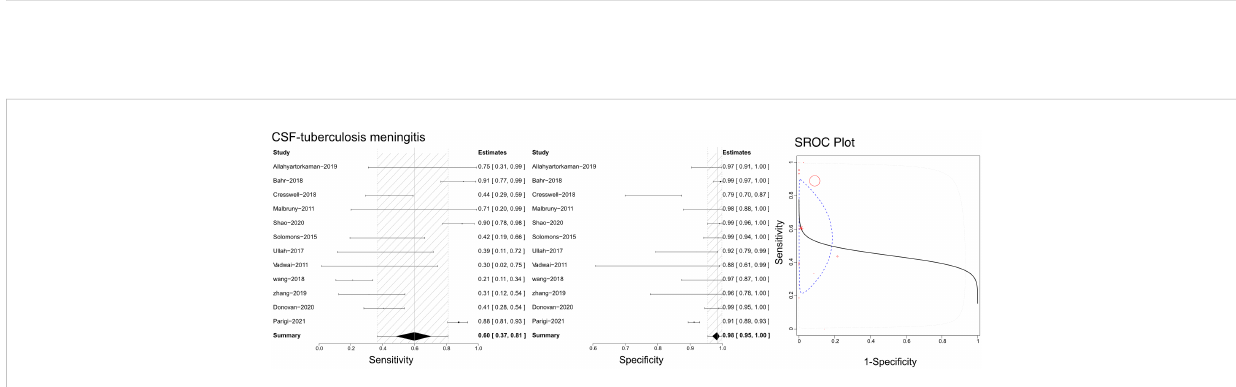
FIGURE 5 The sensitivity, speci fi city and SROC curve of different samples for diagnosing tuberculosis meningitis on cerebrospinal fl uid sample based Xpert analysis.